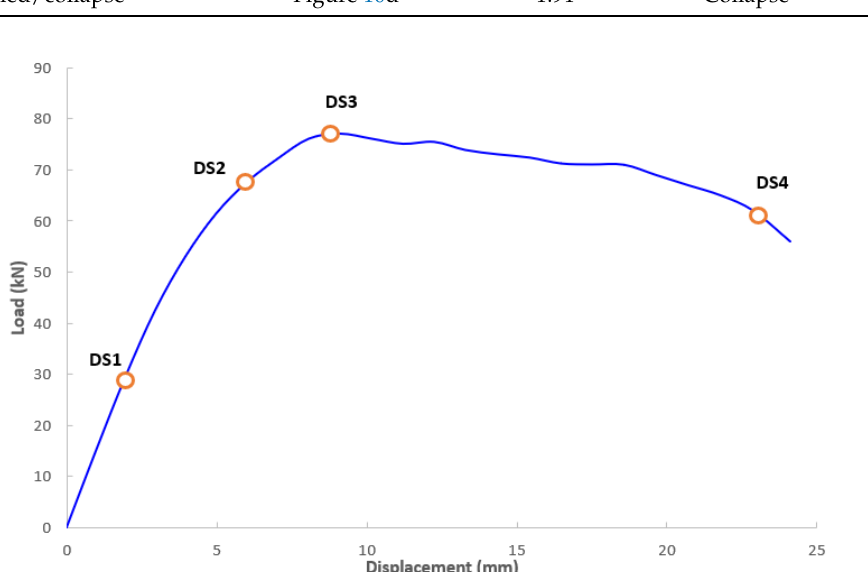
Figure 10. Proposed damage states of the infilled frame (failure mode and crack severity) based on